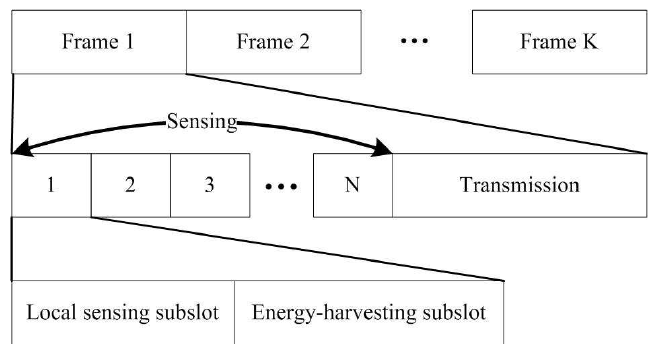
Figure 3. Proposed frame